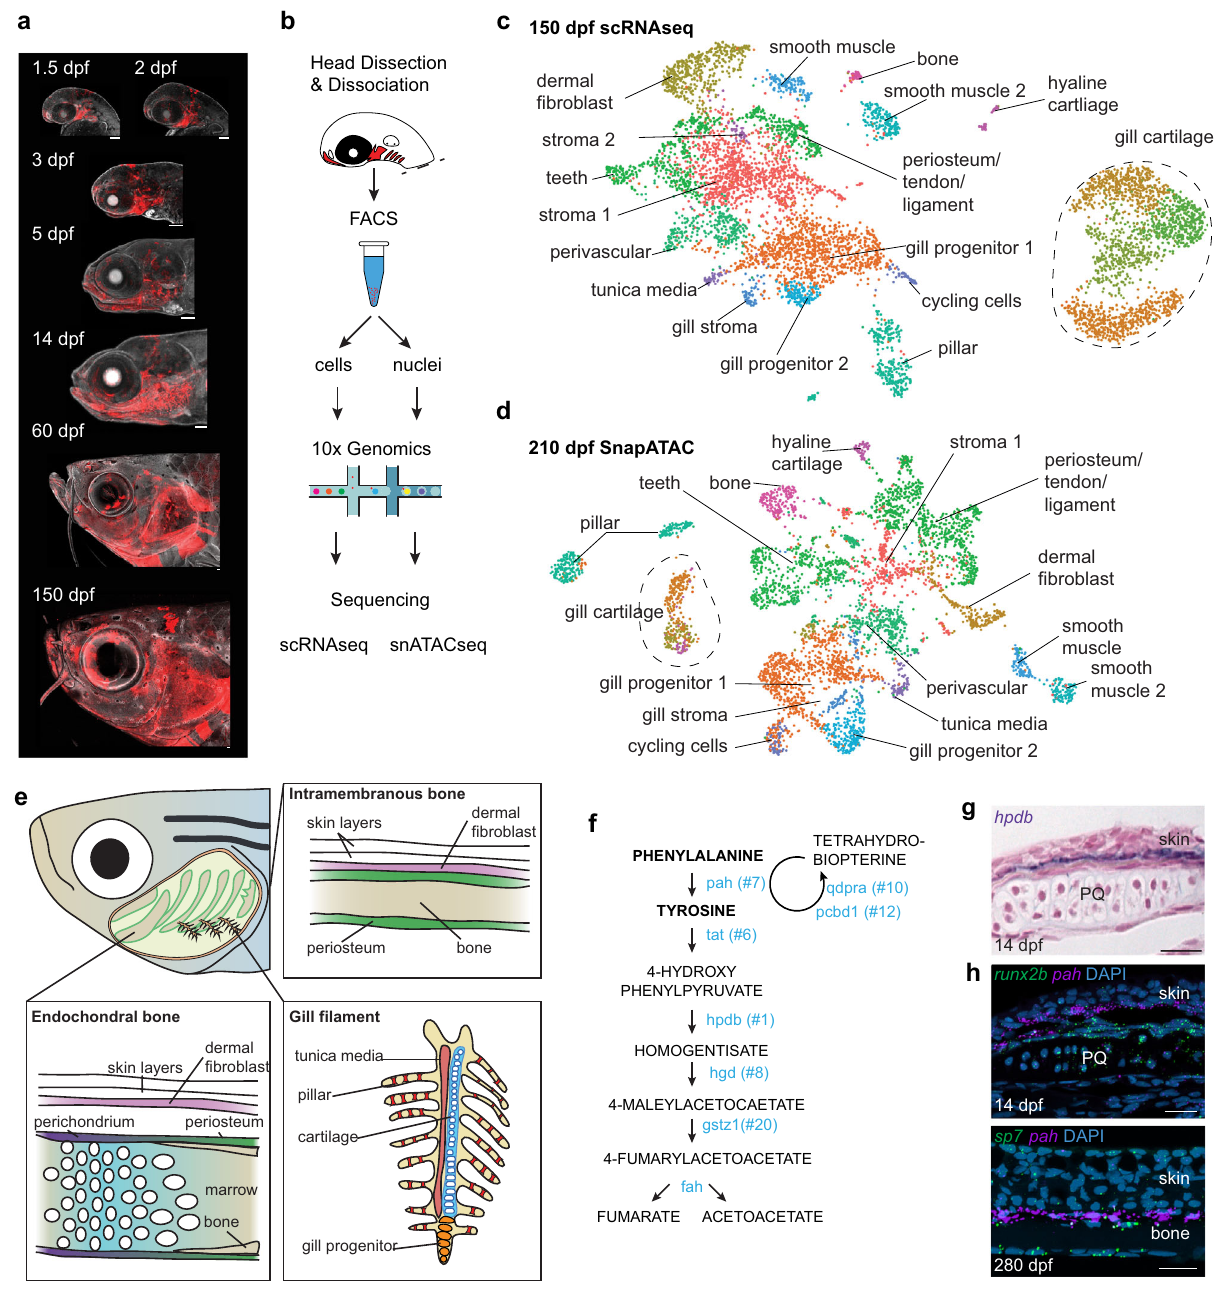
Fig. 1 Single-cell transcriptomes and chromatin accessibility of CNCCs across the zebra fi sh lifetime. a Sox10:Cre; actab2:loxP-BFP-STOP-loxP-dsRed labeling of CNCCs (red) in zebra fi sh heads across 7 stages. b Scheme of cell or nuclei dissociation, fl uorescence-activated cell sorting (FACS), and processing on the 10X Genomics platform for sequencing. c , d UMAPs of scRNAseq and SnapATAC datasets at adult stages. e Diagram of an adult zebra fi sh head cut out to show major cell types of the interior skeletal elements and gill system. f Pathway for Phe and Tyr breakdown. 7 of 8 genes encoding catabolic enzymes are in the top 20 selectively enriched genes for the dermal fi broblast cluster (numbers show rank). g Section colorimetric in situ hybridization for hpdb RNA shows expression in the dermis between the skin and palatoquadrate (PQ) endochondral bone. h Section RNAscope in situ hybridizations show pah expression in dermal fi broblasts between the runx2b + periosteum of PQ and skin at 14 dpf, and between sp7 + osteoblasts of intramembranous bone and skin at 280 dpf. DAPI labels nuclei in blue. Scale bars, 100 μ m ( a ), 20 μ m ( g , h gill-associated clusters include an fgf10b + gill progenitor popu- By creating an index for ectomesenchyme-enriched gene lation, gill chondrocytes, pillar cells, and tunica media cells expression at 1.5 dpf, a stage preceding the onset of differentia- (Fig. S10). Starting at 3 dpf, dermal fi broblasts form a separate tion, we found no evidence for retention of ectomesenchyme branch in both scRNAseq and snATACseq STITCH plots, and identity at later stages, as shown by aggregated ectomesenchyme cxcl12a + stromal cells and teeth are closely associated with less gene expression and the early ectomesenchyme marker nr2f5 19 (Fig. S12). Although formation of CNCC ectomesenchyme differentiated mesenchyme in the center of the plots (Fig. 2a, b; involves a transient reacquisition of the pluripotency network 16 , Figs. S9, S11).